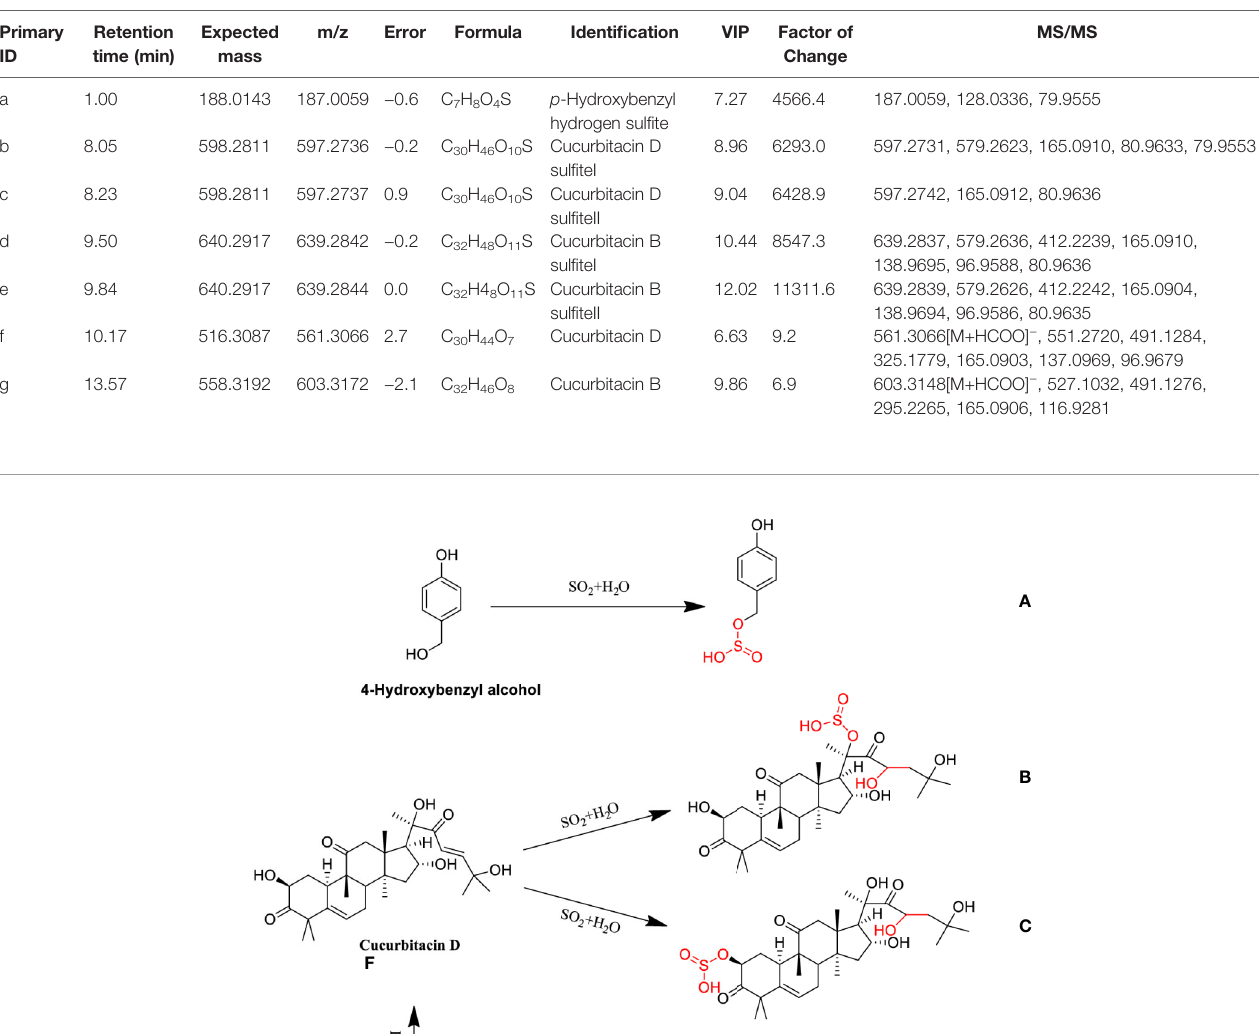
TABLE 1 | Seven sulfur-fumigation markers of TR.